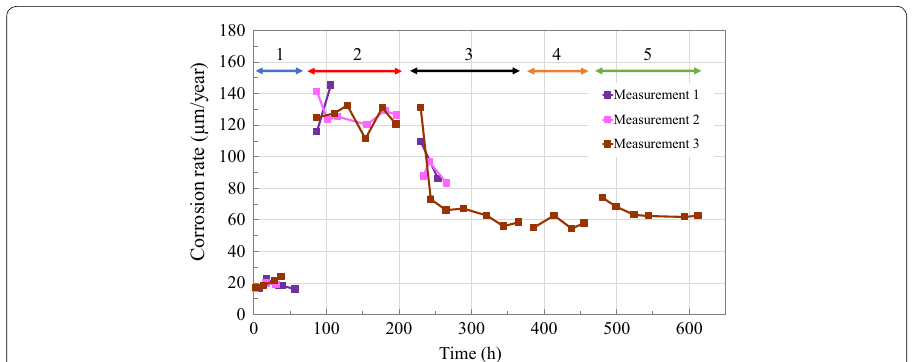
Fig. 5 Corrosion rates (μm/year) obtained from the R p measurements performed with the API steel grade L80 at two different temperatures (90 and 180 °C) and in the presence and absence of oxygen, as described in Fig. 2. Measurements were repeated three